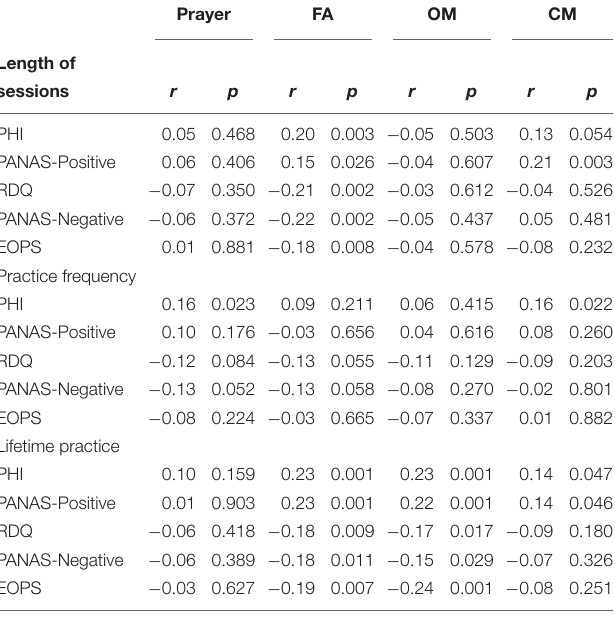
TABLE 1 | Descriptive data for religious belief status, practice-related variables, and psychological adjustment outcomes.